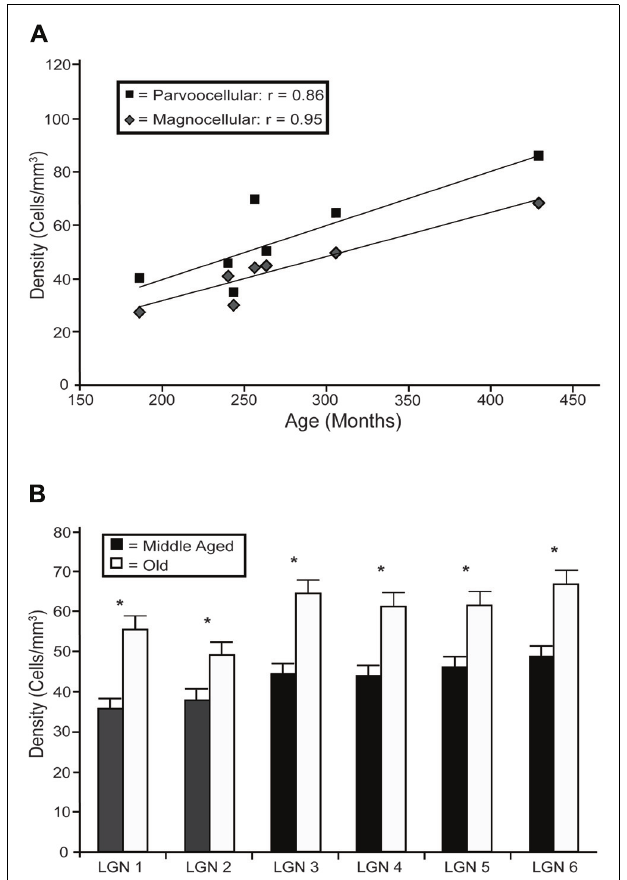
FIGURE 5 |Age-related changes in PV positive neuron density from the layers of the LGN. (A) Regression analyses of the estimated densities of PV + labeled cells from the magnocellular (layers 1 and 2; gray squares) and parvocellular (layers 3 through 6; black diamonds) layers as a function of age showed significant correlations in all layers with the exception of layer 5. (B) Estimated densities of the six individual layers when the animals were combined into middle aged and old age groups revealed significant increases in all LGN layers. Asterisks indicate significance by an unpaired t -test at an alpha level of 0.01.